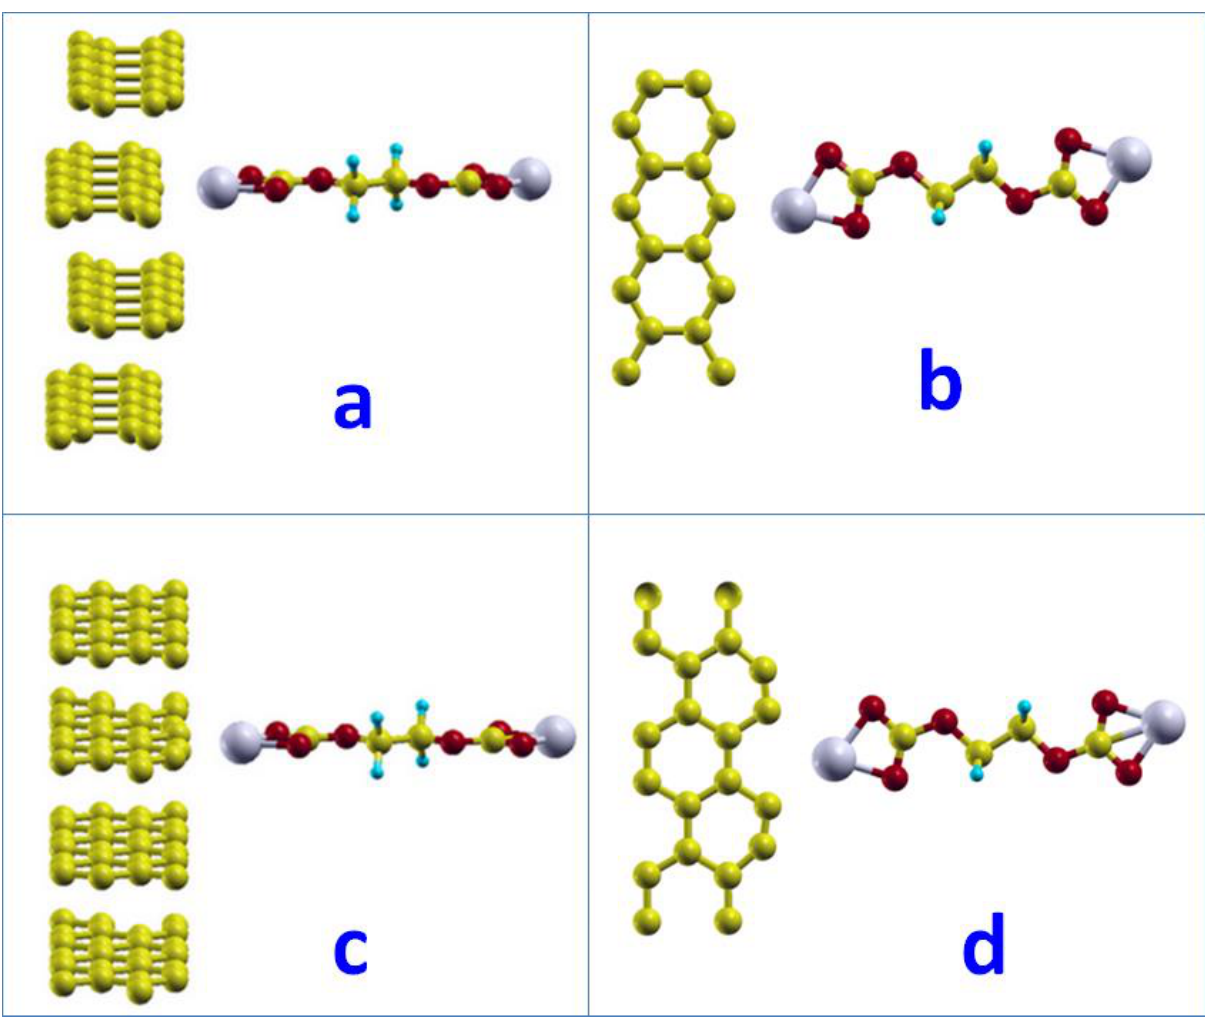
Figure 4. Adsorptions of (CH 2 OCO 2 Li) 2 on the graphite edge surfaces: ( a ) zigzag surface side view; ( b ) zigzag surface top view; ( c ) armchair surface side view; ( d ) armchair surface top view.